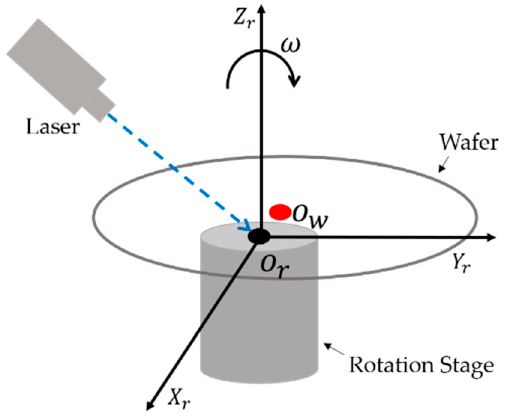
Figure 2. Schematic diagram of alignment of wafer center and turntable center.